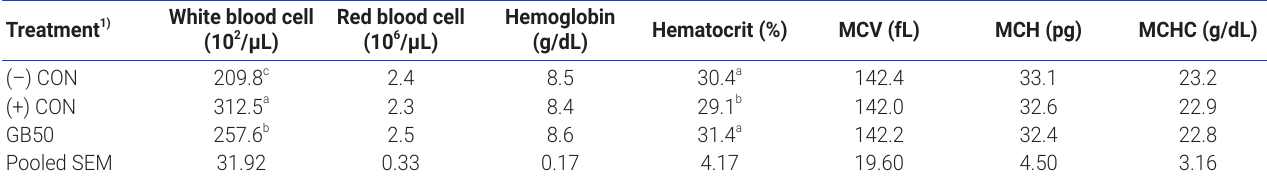
Table 6. Effects of overcrowding stress on blood cell count (Trial 3) Treatment 1)